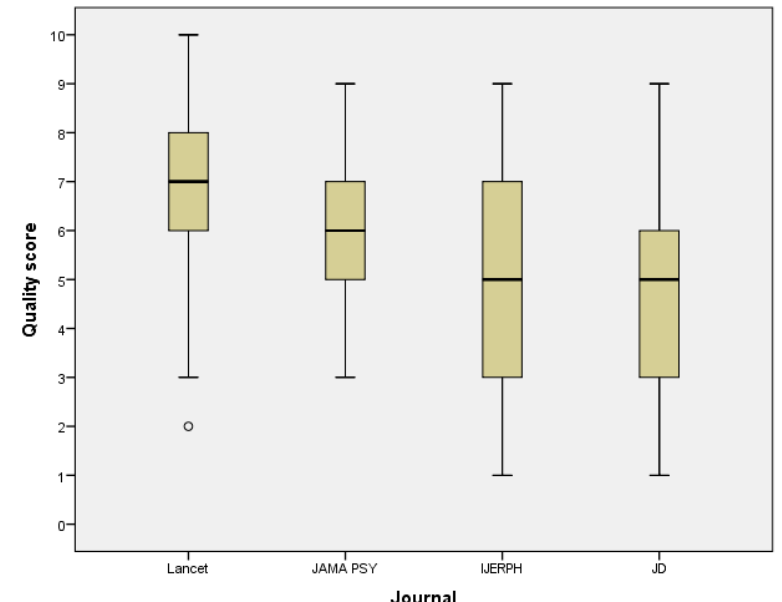
Figure 2. Box plot graph of the data analysis reporting quality score of 160 articles published in four journals. There were 40 articles from each journal. JAMA Psy = JAMA Psychiatry , IJERPH = International Journal of Environmental Research and Public Health, and JD = Journal of Dentistry .